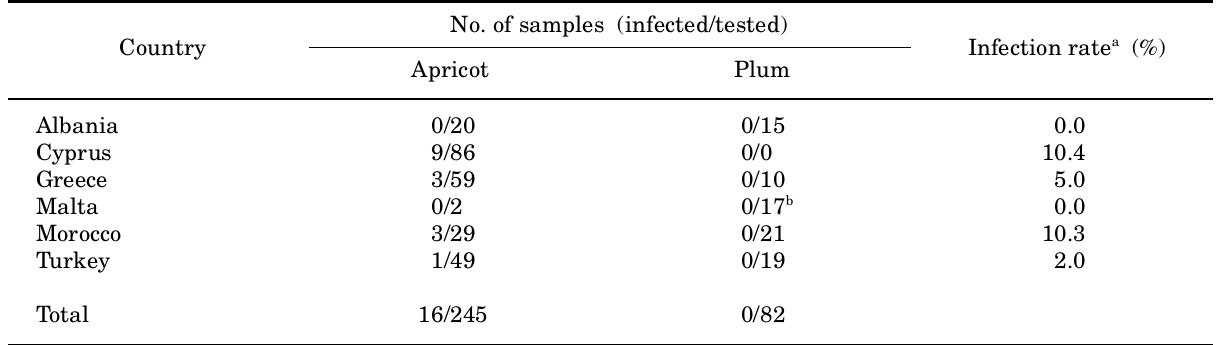
Table 1. HSVd incidence in some Mediterranean countries.